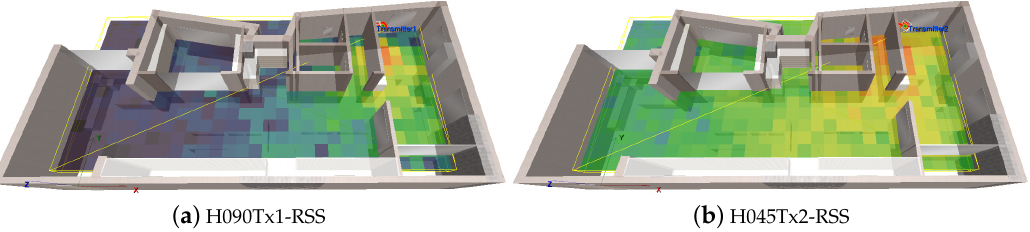
Figure 3. Radiomap vs. antenna polarization, H090 and H045.